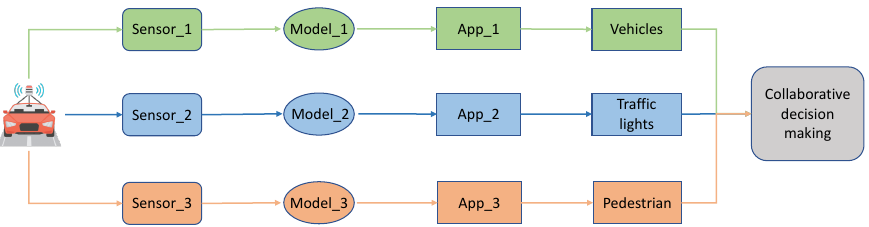
Figure 2. Data processing procedure of object detection and surrounding environment perception in autonomous driving.